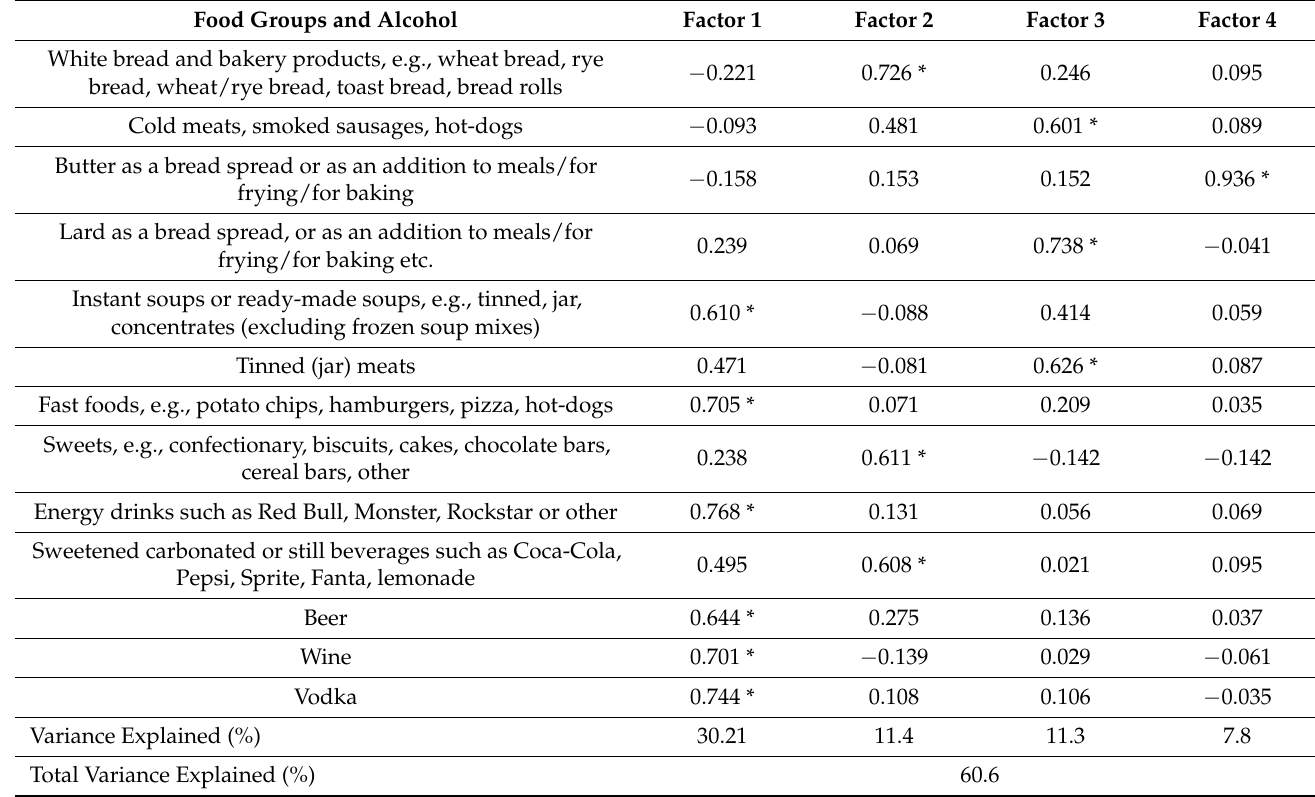
Table 1. Factor-loading matrix for the dietary patterns DPs identified by principal component analysis (PCA; correlation coefficients). Food Groups and Alcohol Factor